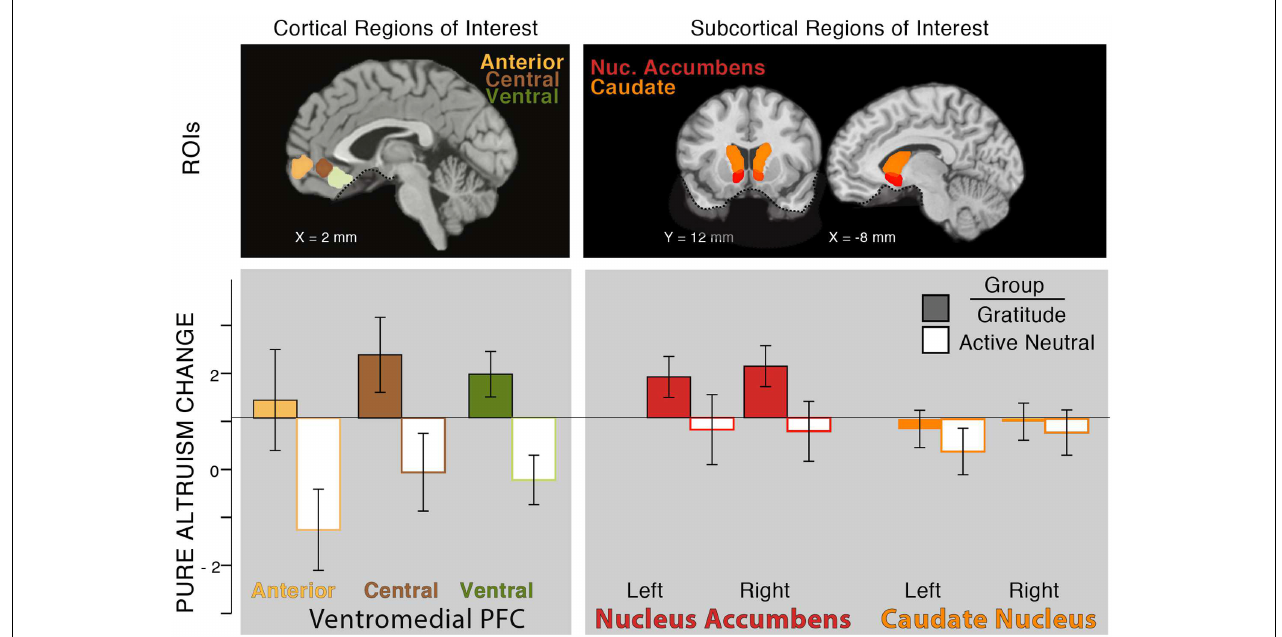
FIGURE 4 | Effect of intervention on neural pure altruism in seven a priori ROIs implicated in previous research (Hubbard et al., 2016). The insets show the locations of the ROIs: VMPFC ROIs (left panel) are those reported in Clithero and Rangel (2014). Subcortical ROIs (right panel) are Harvard Oxford atlas locations at a threshold of 30%. The dashed line in ventral regions of the brain shows the limit of our sampling of the brain due to magnetic susceptibility artifacts. Neural pure altruism is operationalized as the contrast between the neural response to charity-gains versus self-gains for mandatory transfers of money; the Y -axis represents the change in neural pure altruism from pre-test to post-test. The group of participants who completed 3 weeks of gratitude journaling (colored bars) showed an overall increase in the neural pure altruism measure relative to the active-neutral journaling group (white bars) in the